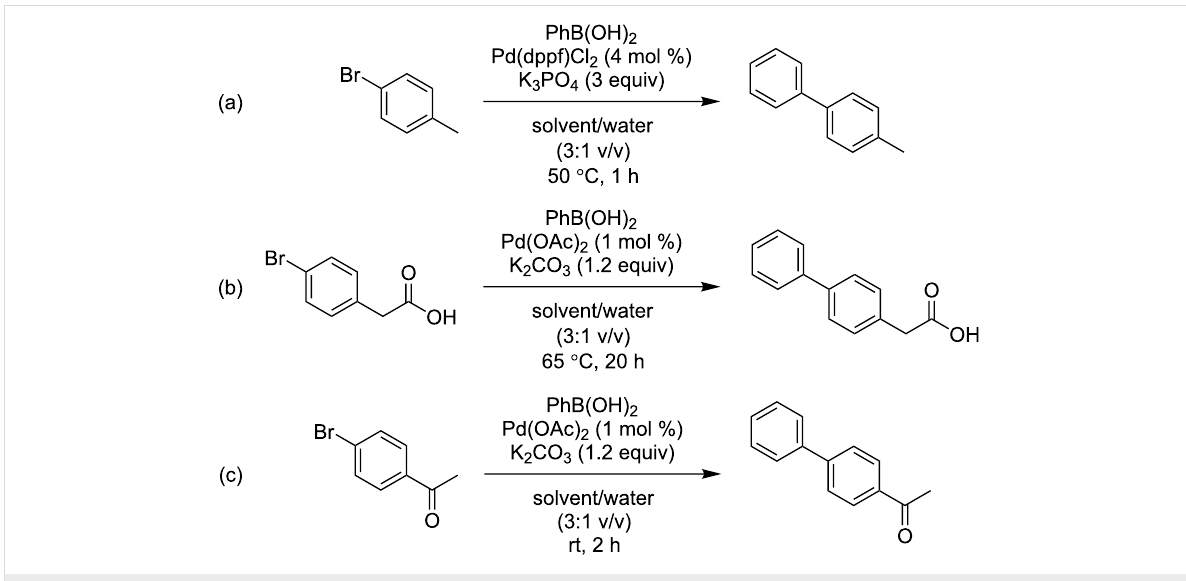
Table 1: Conversions in three Suzuki–Miyaura reactions. a